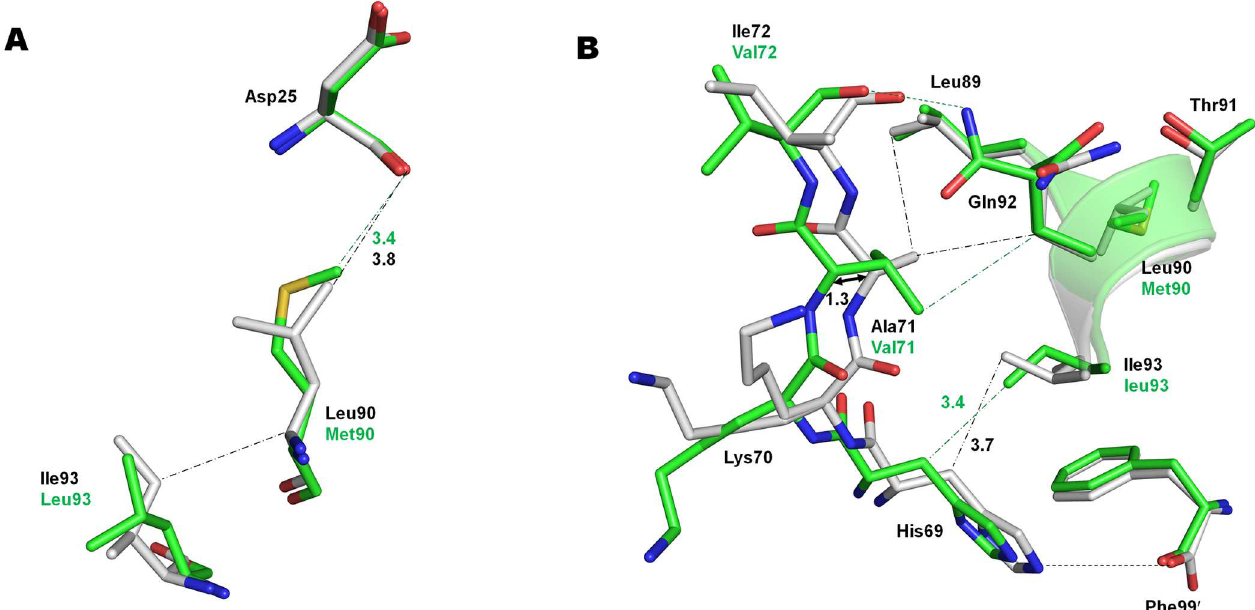
Fig 5. Effects of Distal mutations A71V, L90M and I93L. A. L90M mutation in PR S17 (green)inducesshortenedC-H ... O interaction between Met90 and catalytic Asp25 in comparison to wild-typePR (gray). I93L mutation in PR S17 results in loss of van der Waals contact observedbetween Ile93 and Leu 90 of wild-type PR. B. Distal mutations A71V and I93L in PR S17 are associatedwith shift in 70’s β strand by ~1 Å and loss of the ion pair betweenHis69 and the carboxylatetail of the second subunit.